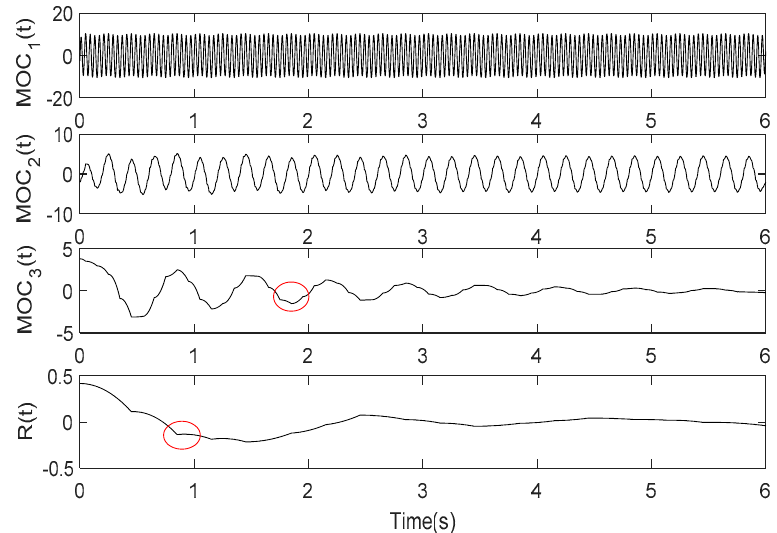
Figure 7. LOD decomposition results of the simulation signal x ( t ). (Red circle: exhibit the poor smoothness of the decomposition results).